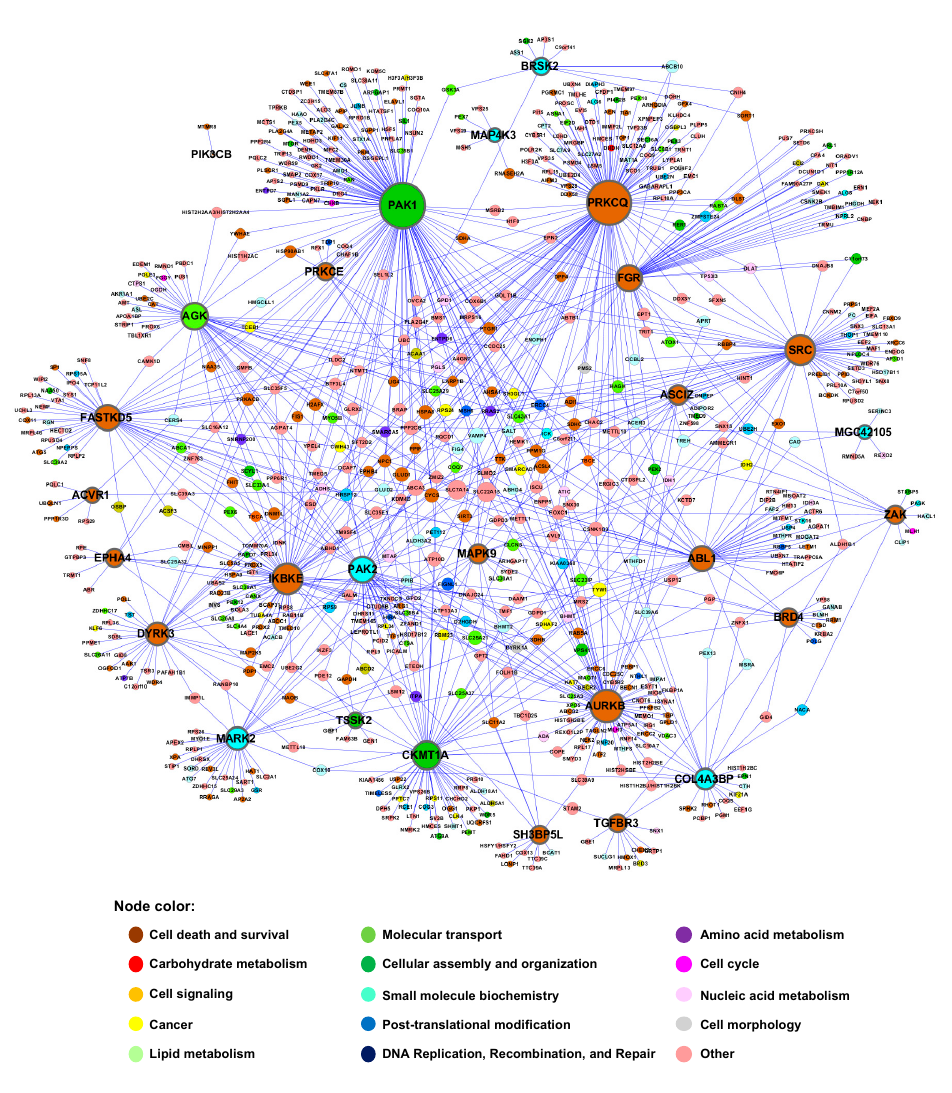
Figure 4. Human–yeast genetic interaction network: kinase interactome network. Human orthologs were identified for yeast genes, the deletion of which suppressed the toxicity of the 28 kinases. A network view of the genetic interactions between these human orthologs and kinases was generated using Cytoscape. The kinase interactome network encompasses the 28 kinases and their 969 genetic interactions. The node color corresponds to the biologic function category to which each gene belongs. The node size is proportional to the number of genetic interactions. Nodes with gray outlines indicate the 28 kinases.